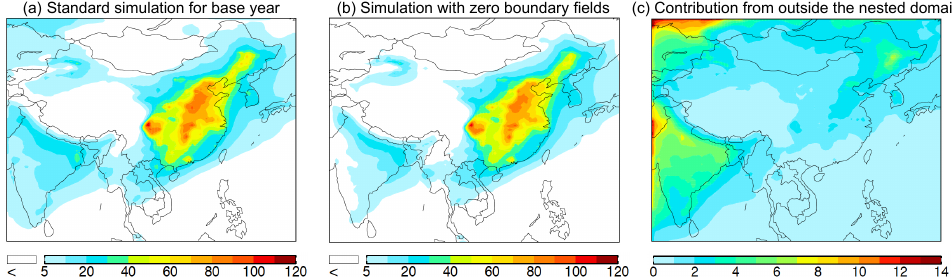
Figure 7. Annual mean contributions from outside the nested domain.